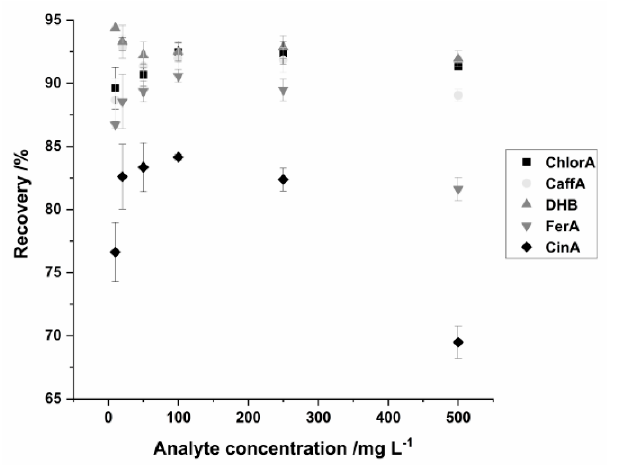
Figure 5. Extraction recoveries obtained from DSPE experiments with the poly(n-VIM/C 6 -bis-VIM) polymer with a monomer to crosslinker ratio of 11.50 to 1, by applying different loading concentrations. Standard deviations are given as error bars.